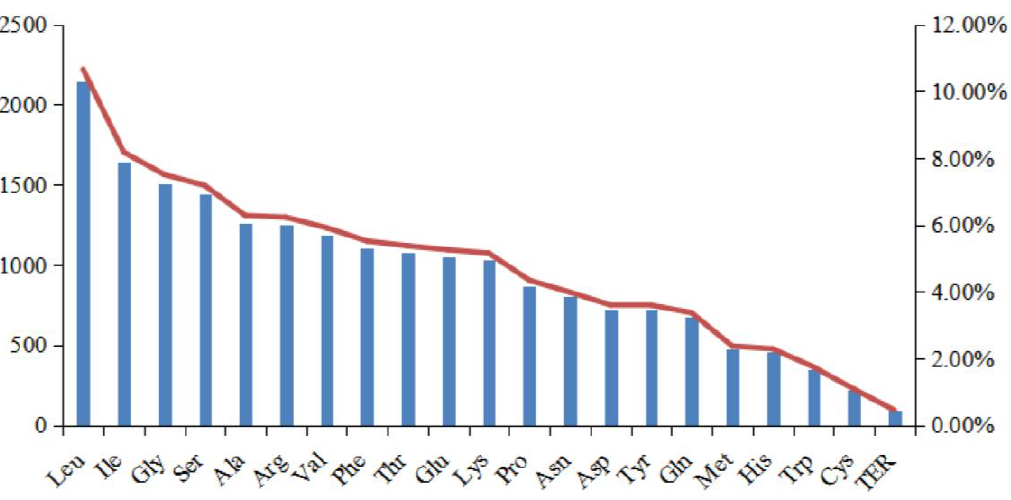
Figure 4. Amino acid frequencies in the Indosasa lipoensis cp genome protein coding sequences (CDS).